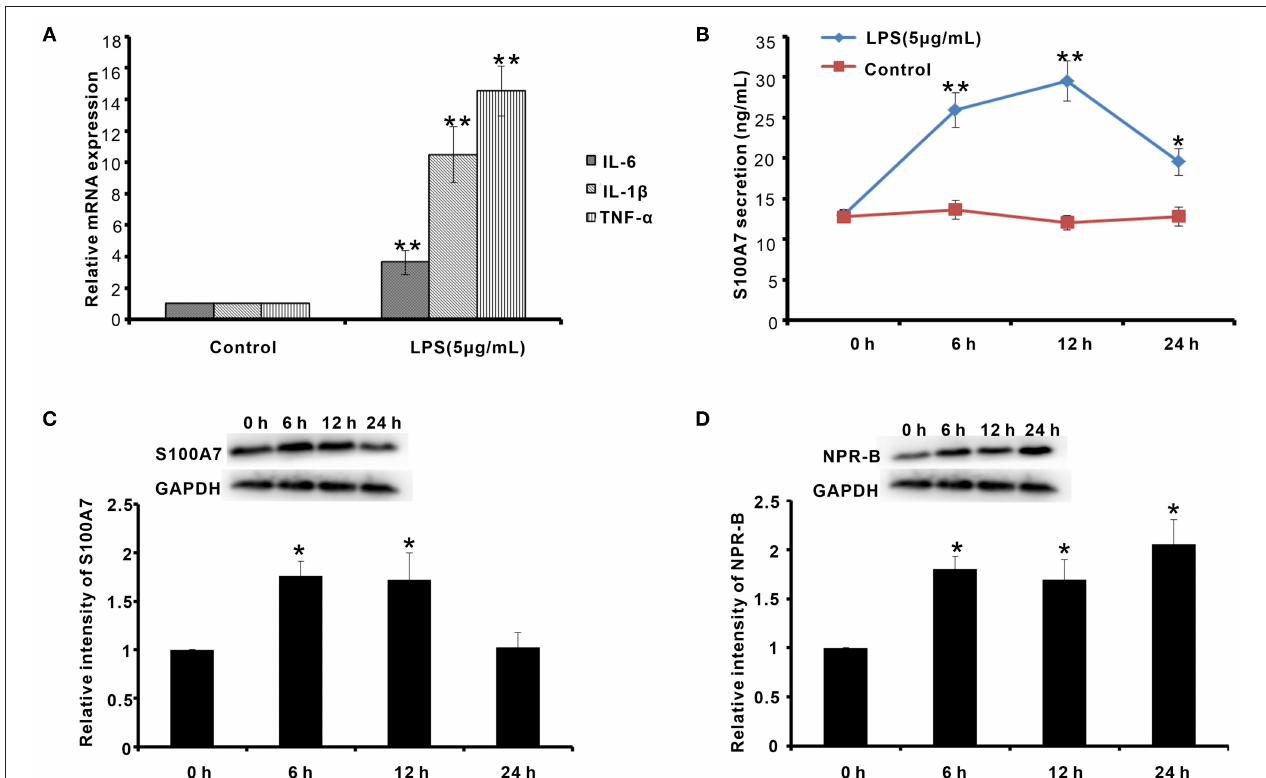
FIGURE 7 | Establishment of goat mastitis model in vitro and the expression of NPR-B and S100A7 in goat mastitis model in vitro . (A) Quantitative PCR results showing the mRNAs expression level of interleukin-6 (IL-6), interleukin-1 β (IL-1 β ), and tumor necrosis factor- α (TNF- α ) in goat MECs treated by 5 µ g/ml LPS for 6h. (B) ELISA results showed the S100A7 concentration in medium in which goat MECs were cultured and treated by 5 µ g/ml LPS for 0, 6, 12, and 24h, respectively. (C) The Western blotting and quantitative analysis results of the S100A7 expression level in goat MECs treated by 5 µ g/ml LPS for 0, 6, 12, and 24h, respectively. (D) The Western blotting and quantitative analysis results of the NPR-B expression level in goat MECs treated by 5 µ g/ml LPS for 0, 6, 12, and 24h, respectively. * p < 0.05 (compared to control); ** p < 0.01 (compared to control). Full-length blots are given in Supplementary Figures S19–S21